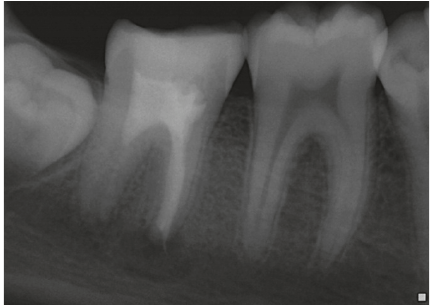
Figure 8: After 3 months from endodontic procedure on mesial roots: reduction of the radiolucent image at the mesial roots; healing of the periapical area at the distal root.